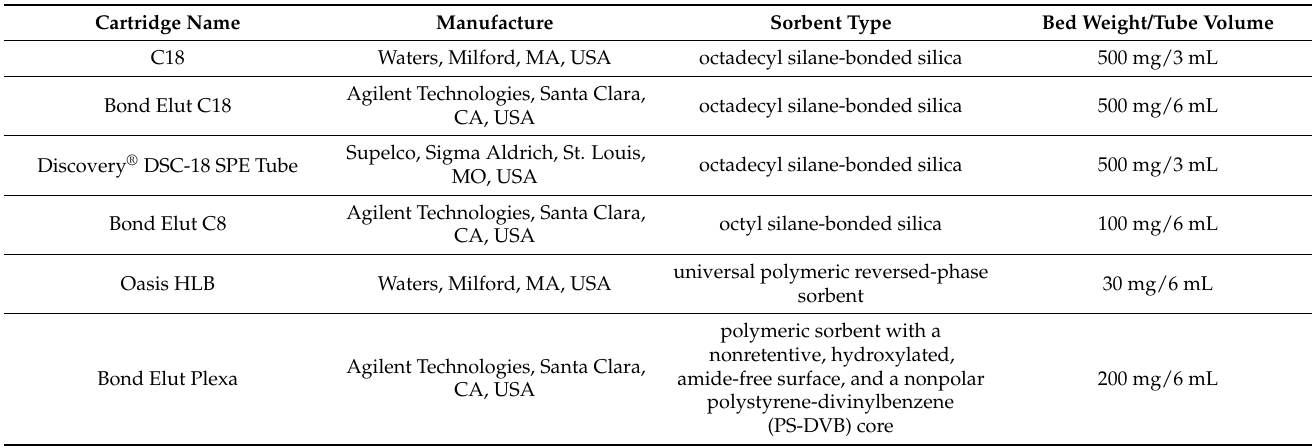
Table 1. List of SPE cartridges used in sample preparation